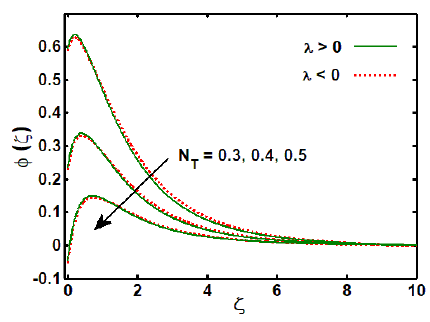
Figure 16. Effects of 𝑁 𝑇 on the 𝜙(𝜁) . Figure 16. E ff ects of N T on the φ ( ζ ) .